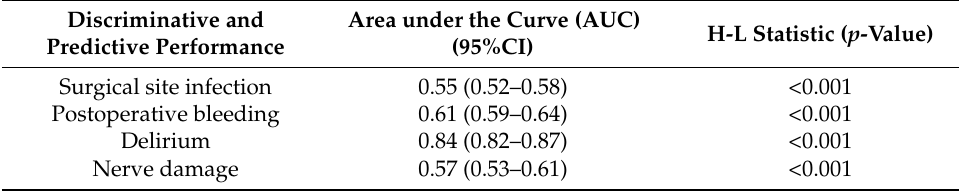
Table 2. Discriminative (AUC) and predictive (H-L) performance per model. Discriminative